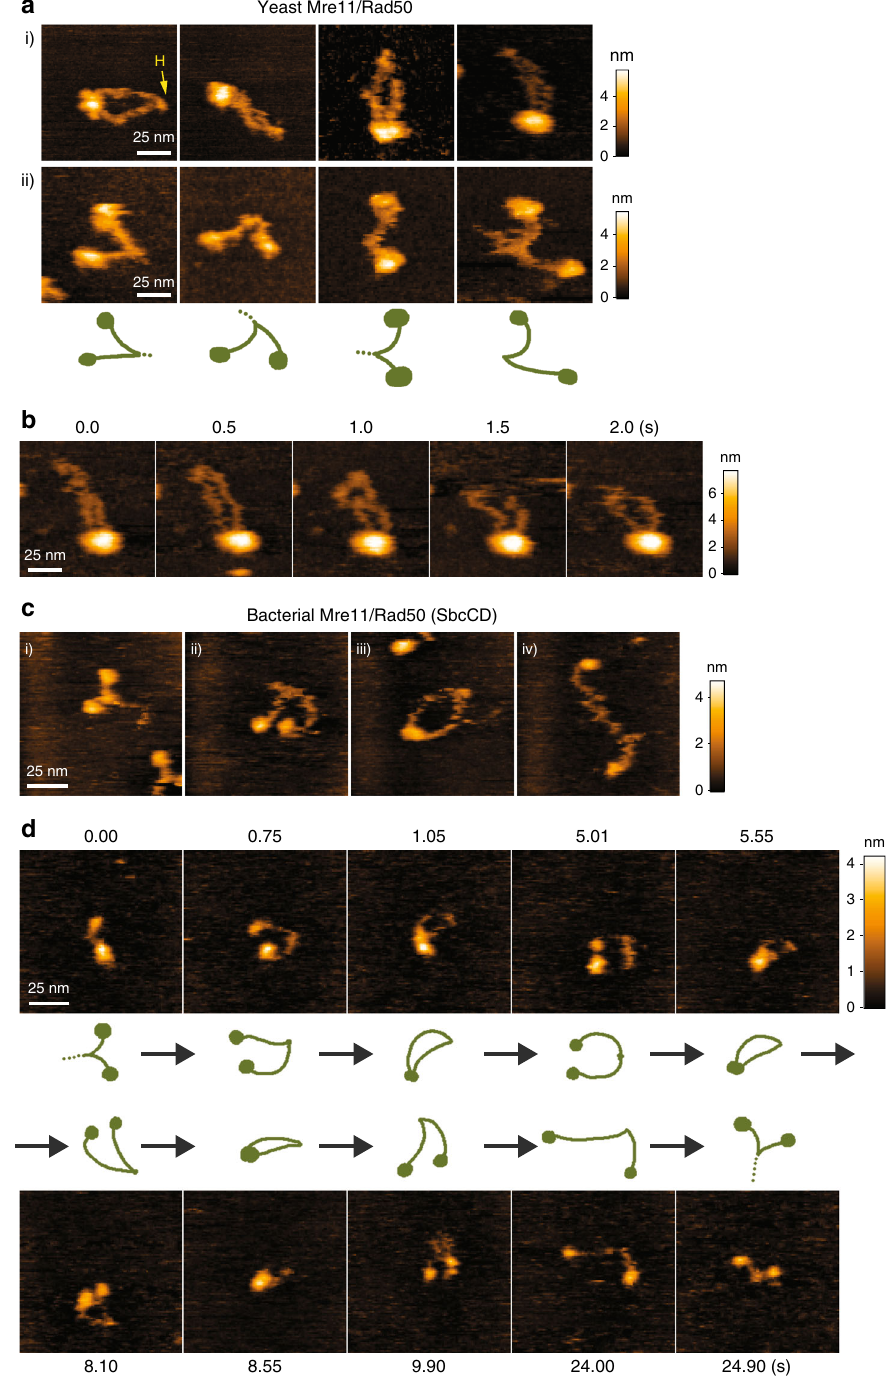
Fig. 3 S. pombe Mre11/Rad50 and E. coli Mre11/Rad50 (SbcCD) are structurally similar to human Mre11/Rad50. a (i) ring and (ii) open/arm-connected structures of S. pombe Mre11/Rad50 ( − ATP). “ H ” : the hook. b Sequential images showing movement of coiled-coil arms of S. pombe Mre11/Rad50. Imaging speed: 500 msec per frame. c Various structures observed with E. coli SbcCD ( − ATP). (i) open/arm-connected, (ii) head-open, (iii) ring, and (iv) “ S- shaped ” structures. d SbcCD was real-time imaged by adding the protein to the imaging chamber while scanning ( − ATP). The structural transients are shown. Imaging speed: 150 msec per frame. Scan size, 100 × 100 nm. Representative images selected from the movie of a single SbcCD molecule (Supplementary Movie 7) are shown with schematic diagrams of presumed